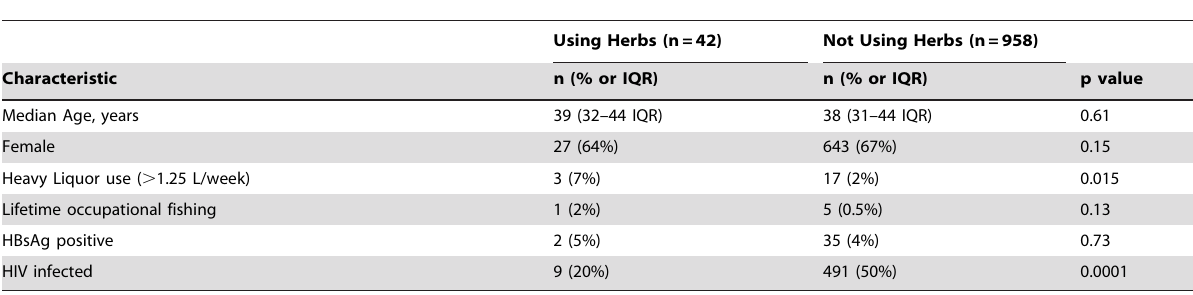
Table 2. Characteristics of participants reporting current herb use.